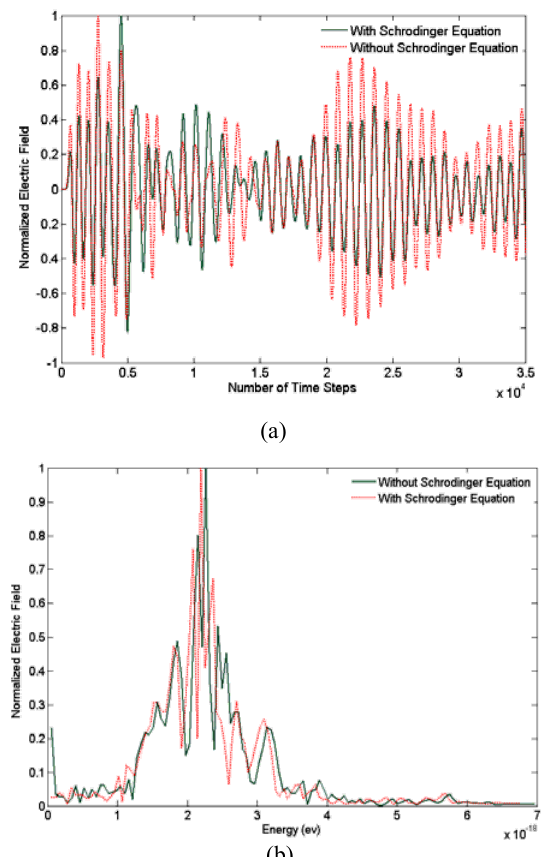
Fig. 5: Field plot for struc ture 3(a), (a) Electric field with respect to number of t ime s teps wi th a nd wi thout Schrödinger equa tion, b) El ectric fiel d w ith respec t t o energy (eV) with and without Schrödinger